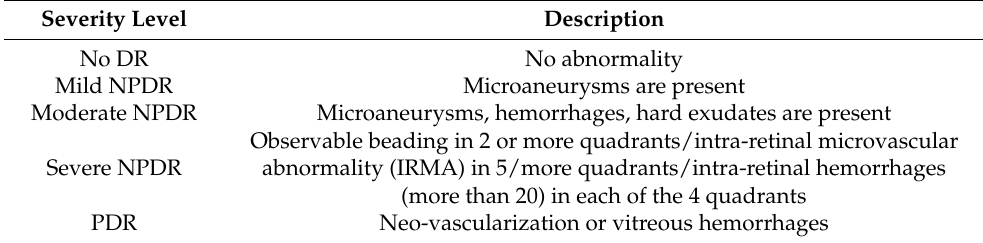
Table 1. DR stages